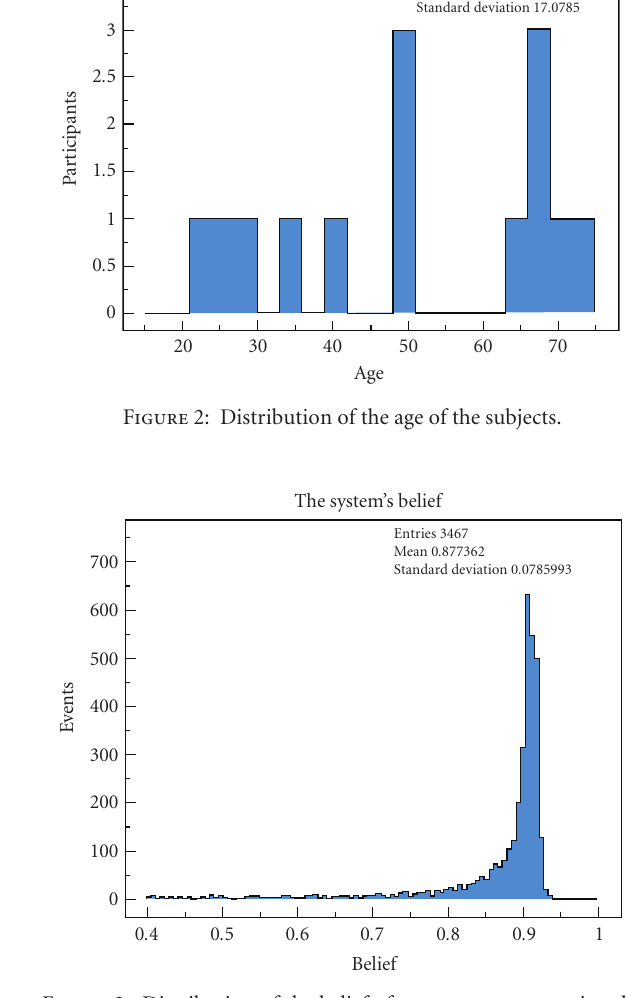
Figure 3: Distribution of the belief of our system, regrouping the data from the whole